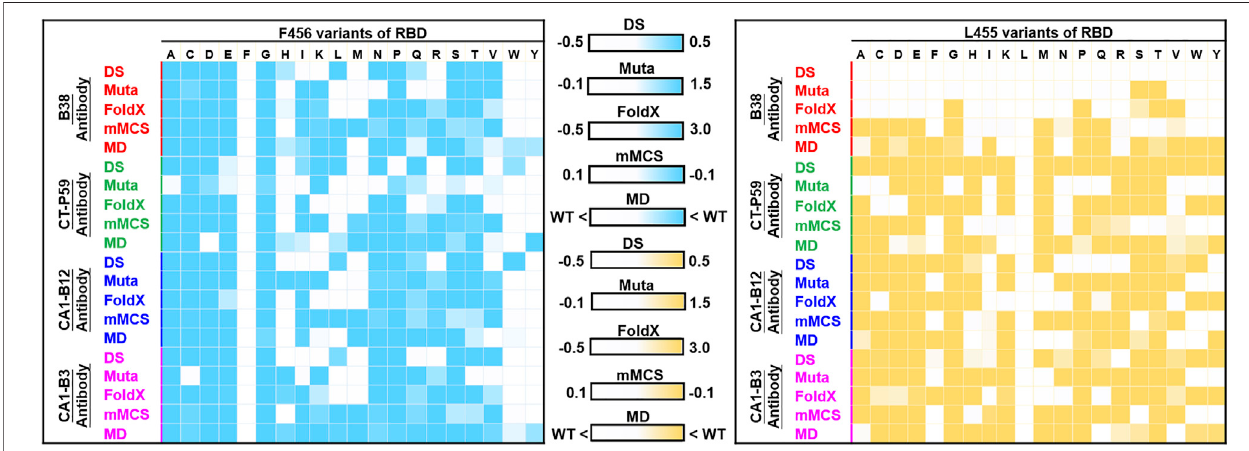
FIGURE 12 | Comparison of MD and non-MD predictions of the mutational effects of F456 and L455 RBD variants targeting convalescent antibodies. The unit of binding stability (DS, Mutabind2 (Muta), FoldX, and mMCS-PPI2 (mMCS)) and af fi nity (MD) were in kcal/mole, and the obtained values were employed to create the heatmaps. In DS, Muta, FoldX, and mMCS, white (increased stability) and blue/yellow (reduced stability) are used to generate a color gradient and were applied in each box. In MD results, the predicted binding af fi nity smaller than that of wild-type (WT) is colored in